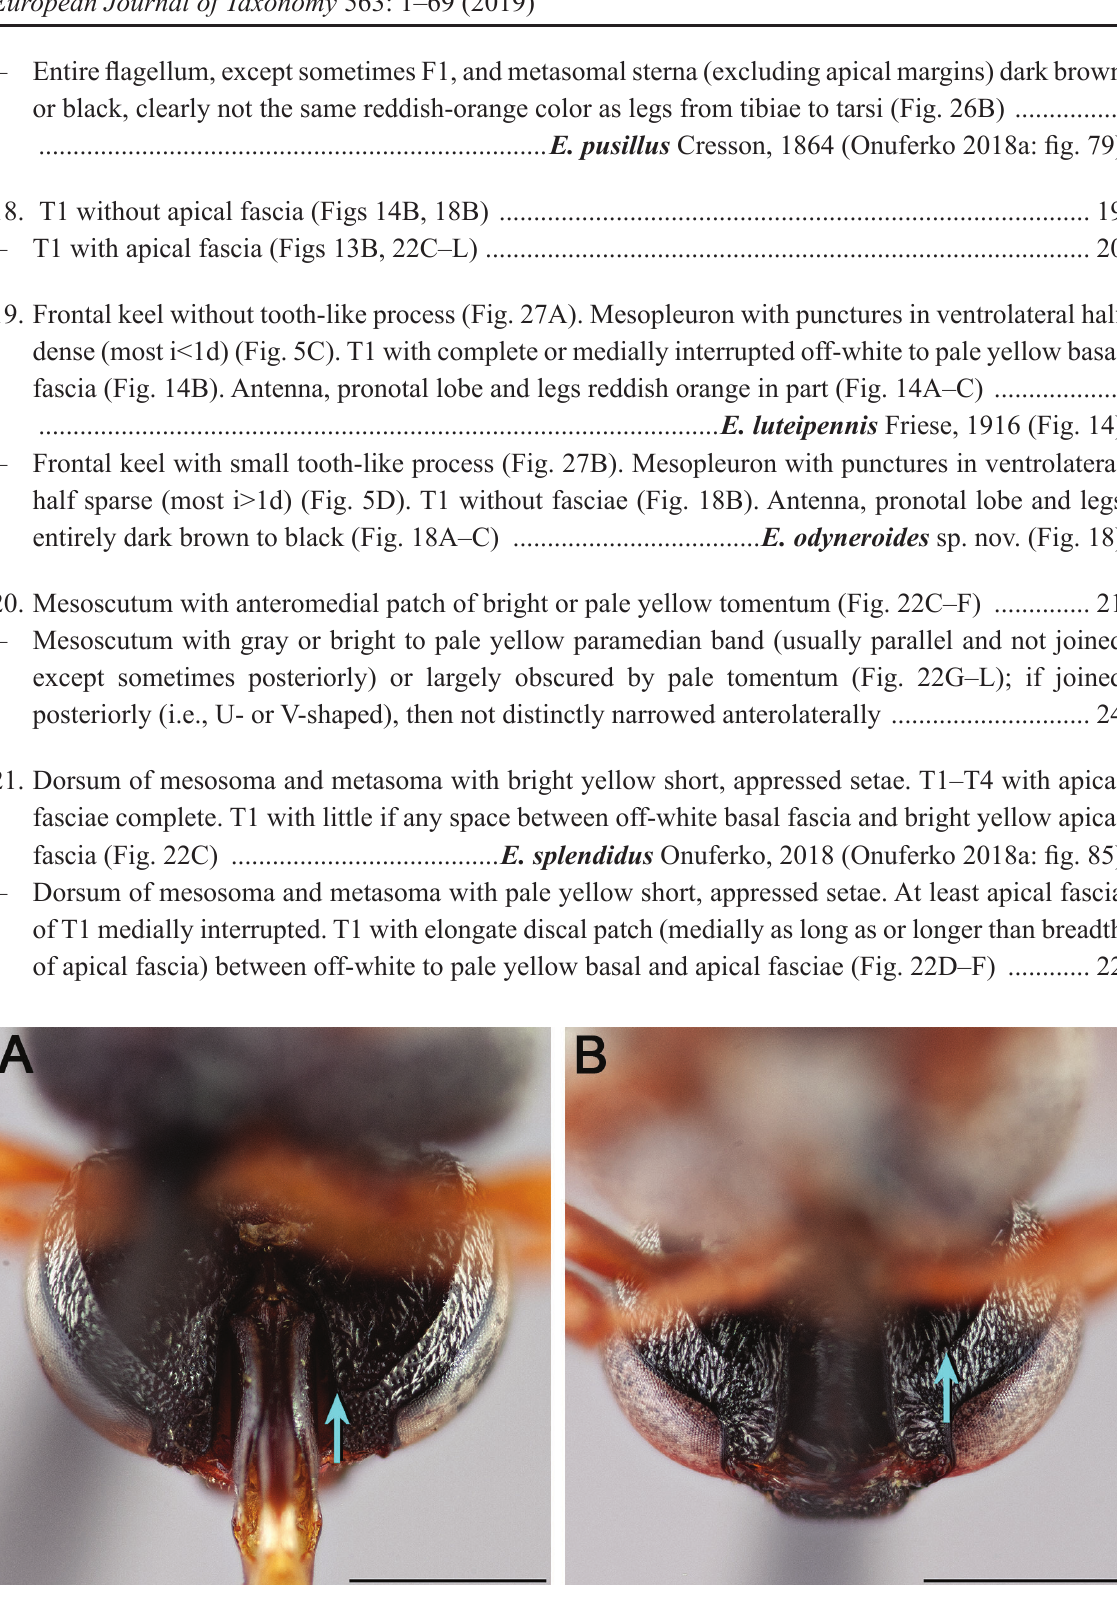
Fig. 23. Head of male, posterior view. A . E. ainsliei Crawford, 1932, in which the preoccipital ridge joins the hypostomal carina (blue arrow). B . E. rufulus Cockerell, 1941, in which the preoccipital ridge does not join the hypostomal carina (blue arrow). Scale bars = 1